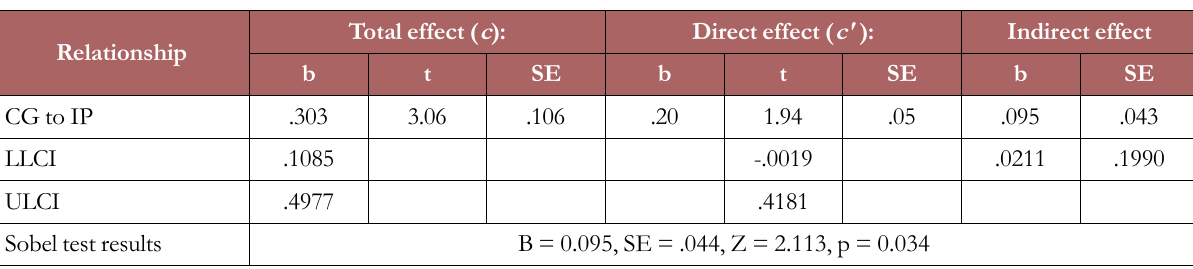
Table 6. Direct, and indirect effects of RG on Innovation performance through Social